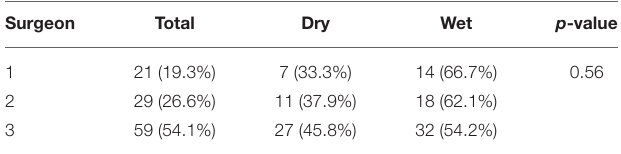
TABLE 2 | Distribution of patients in “dry” and “wet” between the surgeons. Surgeon